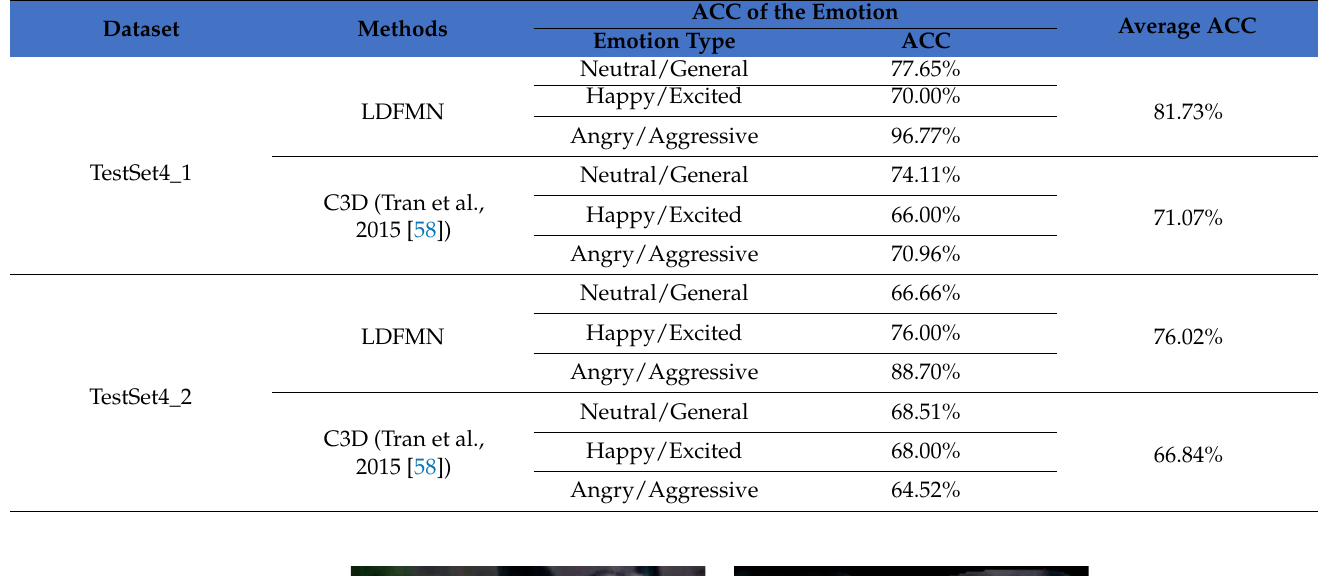
Table 15. Results of dog emotion recognition experiments.